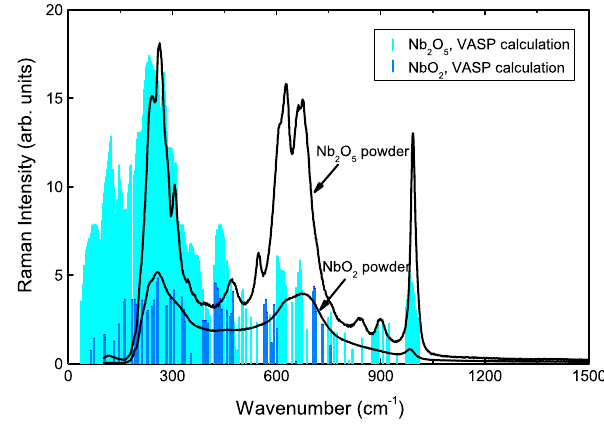
FIG. 2. Experimental Raman spectra of Nb 2 O 5 and NbO 2 powders (black lines) along with DFT calculations of the Raman DOS for Nb 2 O 5 (light blue) and NbO 2 (dark blue).